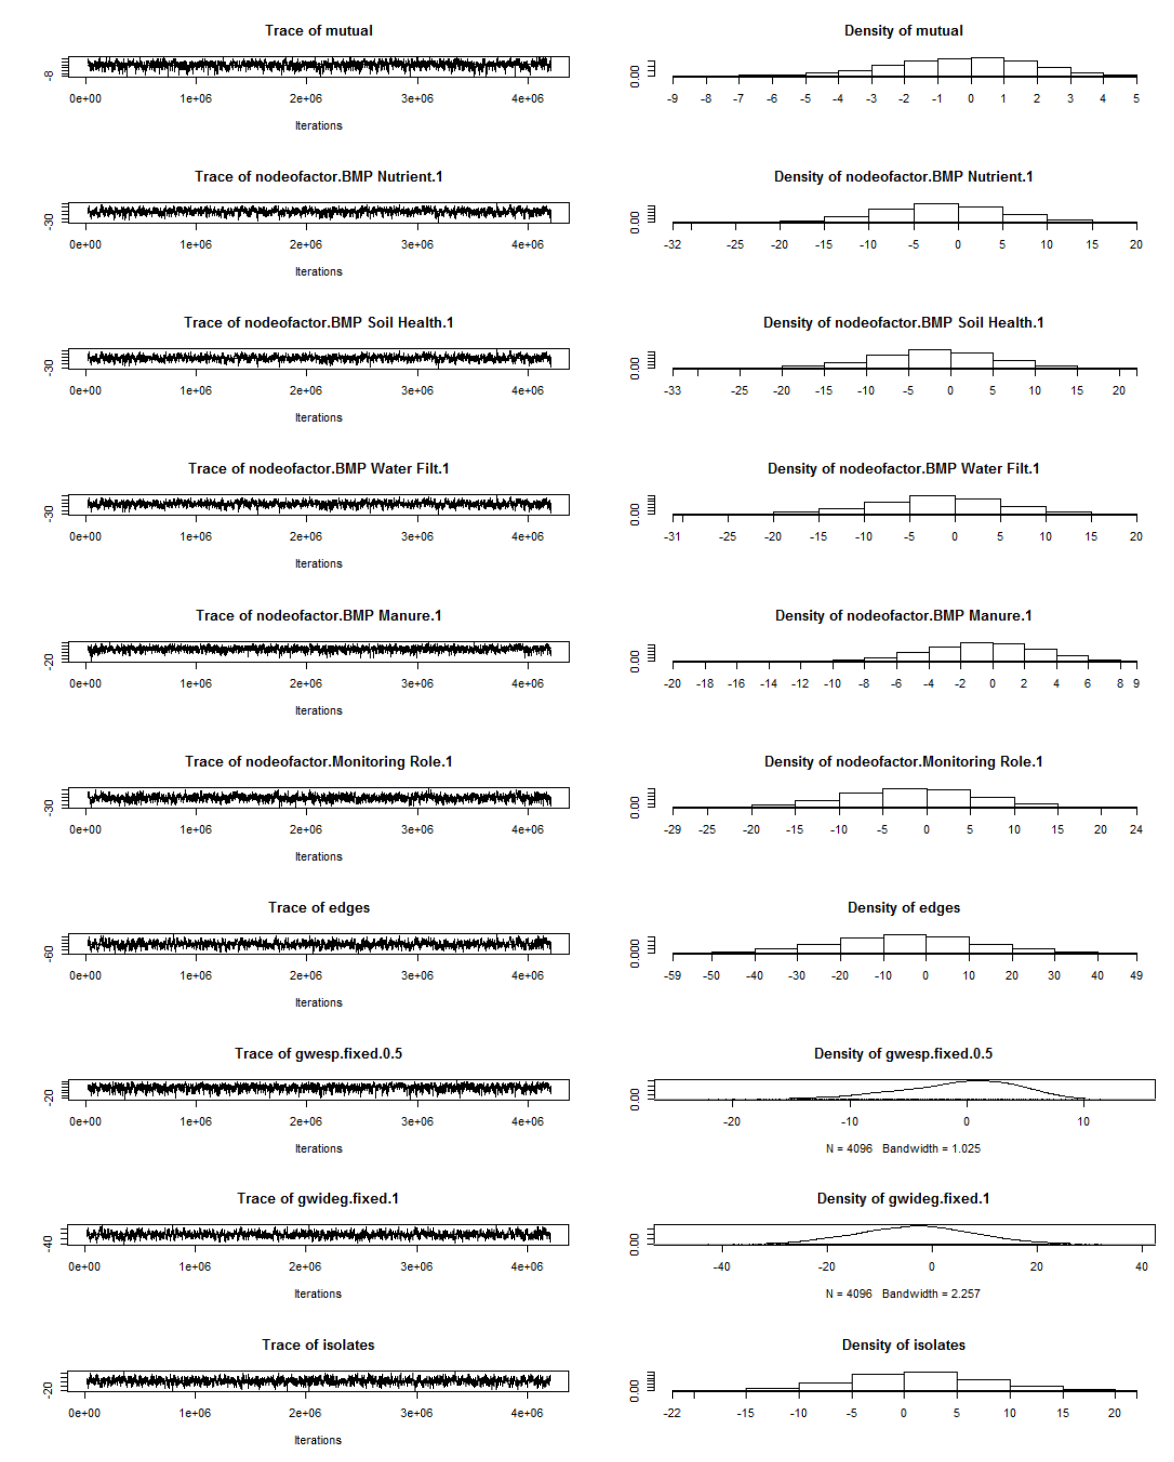
Figure A1.6. MCMC Chains for Modeled Statistics (normally distributed chains indicate proper model